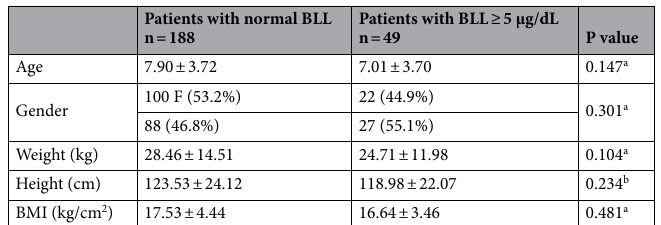
Table 1. Demographic data of the patients. Duration of constipation was more than 2 months in both groups . a Mann–Whitney U-test. b Student’s T-test.